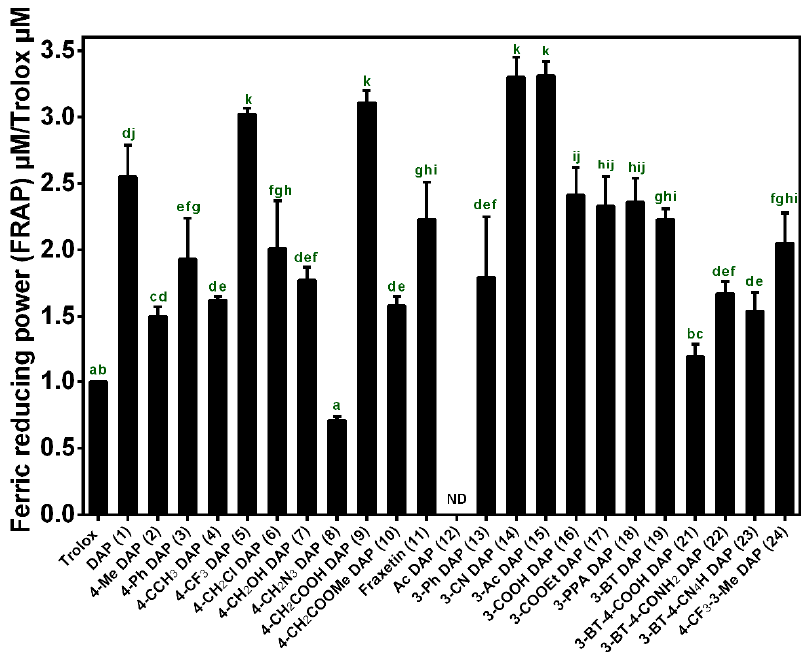
Figure 2. Ferric reducing power of daphnetin and its derivatives. Values marked by the same alphabet are not significantly different ( p < 0.05). Table 1. Antioxidant activity of daphnetin derivatives tested in 2,2 ′ -diphenyl-1-picrylhydrazyl (DPPH) and 2,2 ′ -azinobis-(3-ethylbenzthiazoline-6-sulfonate) cation (ABTS + ) assays.DAP = daphnetin.